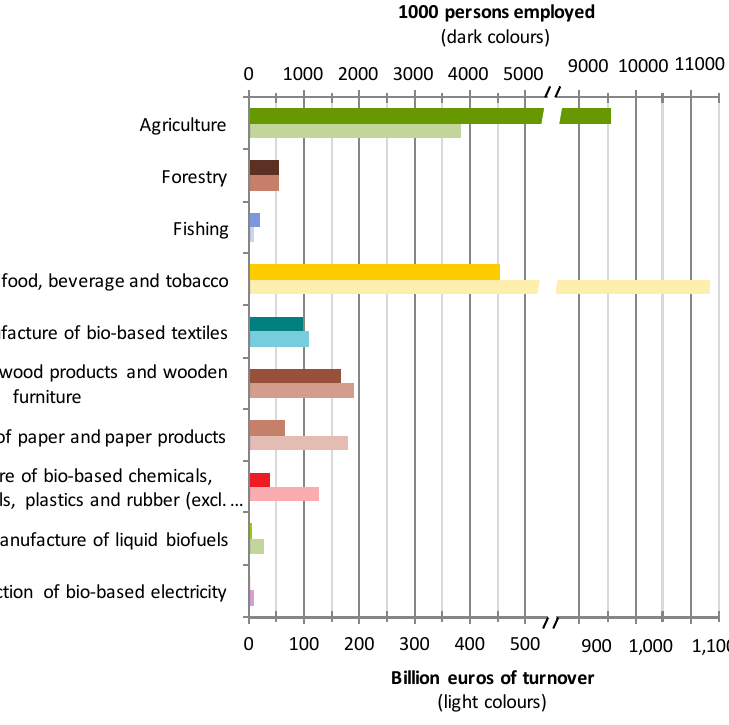
Figure 1. Persons employed and turnover generated in EU-28 bioeconomy sectors